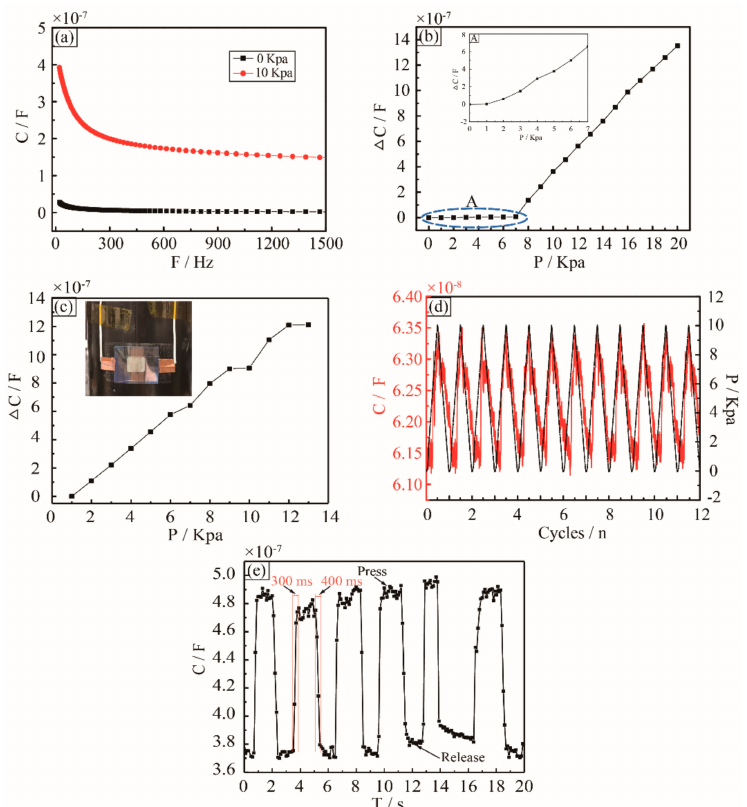
Figure 3. Characterization of the pressure sensing performance of the flexible ionic liquid super-capacitive pressure sensor. ( a ) The capacitance changes with driving frequency sweep from 20 Hz to 1.5 KHz at 0 KPa and 10 KPa, respectively. ( b ) Relative rate of change in capacitance of the sensor as a function of different pressure. The inset shows that the relative rate of change in capacitance of low pressure region A. ( c ) Relationship of the change in capacitance of the sensor attached on a circular tube and pressure applied. The inset shows the actual sensor attached on the circular tube. ( d ) The relationship of pressure and capacitance of the sensor cyclically compressed by 10 KPa. ( e ) The capacitance variation of the sensor under a square shaped pressure